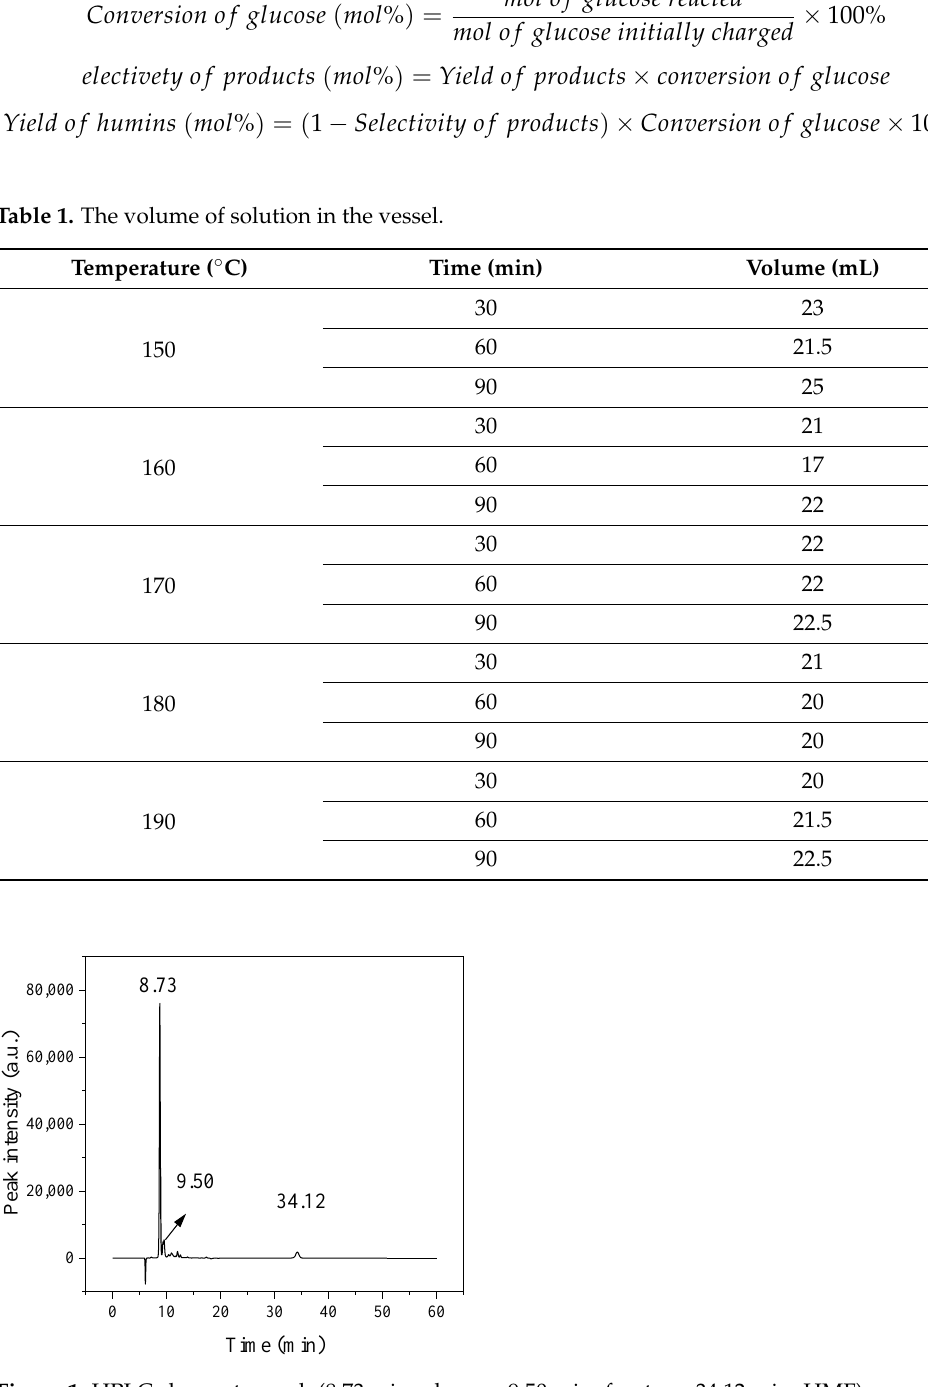
Figure 1. HPLC chromatograph (8.73 min: glucose; 9.50 min: fructose; 34.12 min: